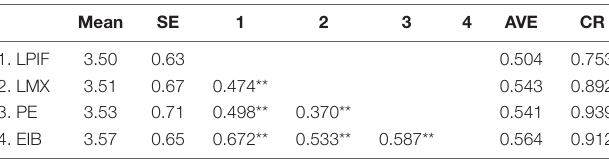
TABLE 2 | Correlation analysis of variables and discriminant validity